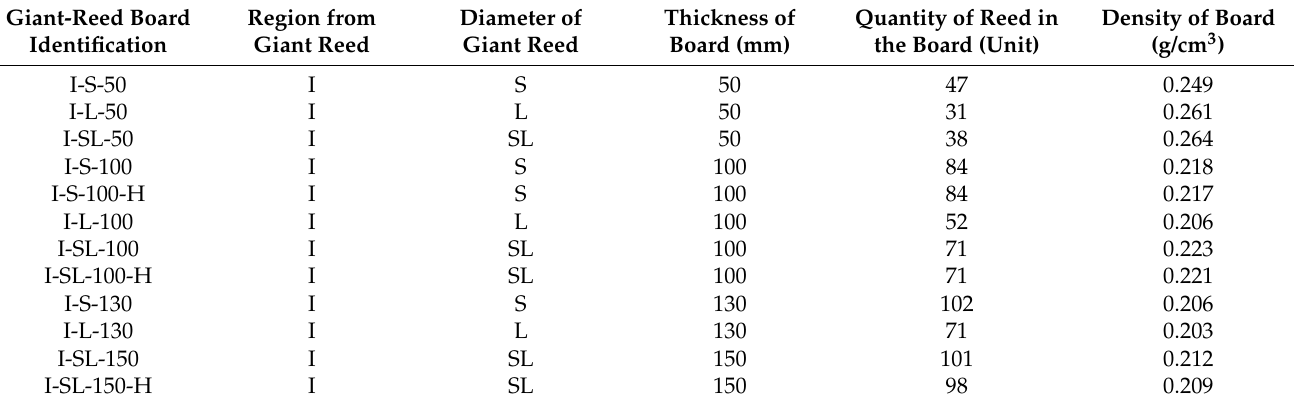
Table 3. Identification and main characteristics of giant-reed boards from Region I.